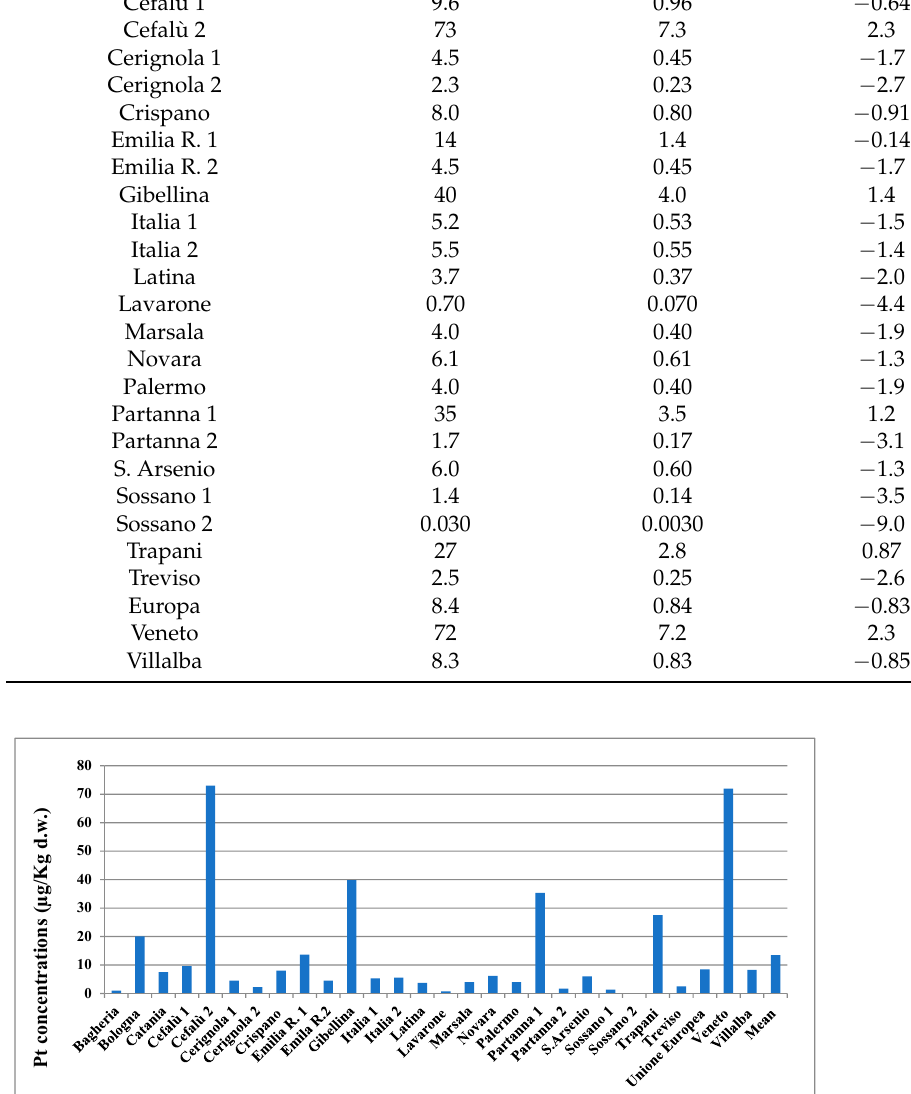
Table 1. Platinum concentrations ( µ g kg − 1 ), Enrichment factors (EF), and Geoaccumulation index (I geo ), measured on mushroom samples.